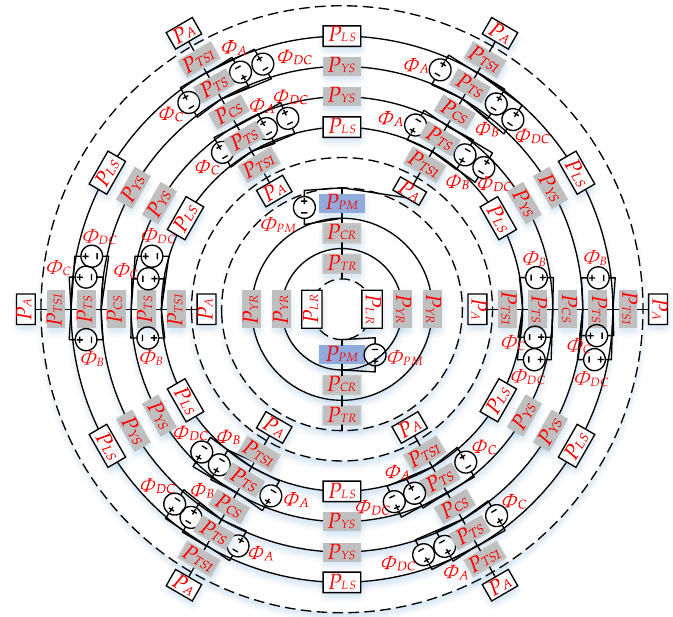
Figure 2. NVNMC model of CPPM machine.